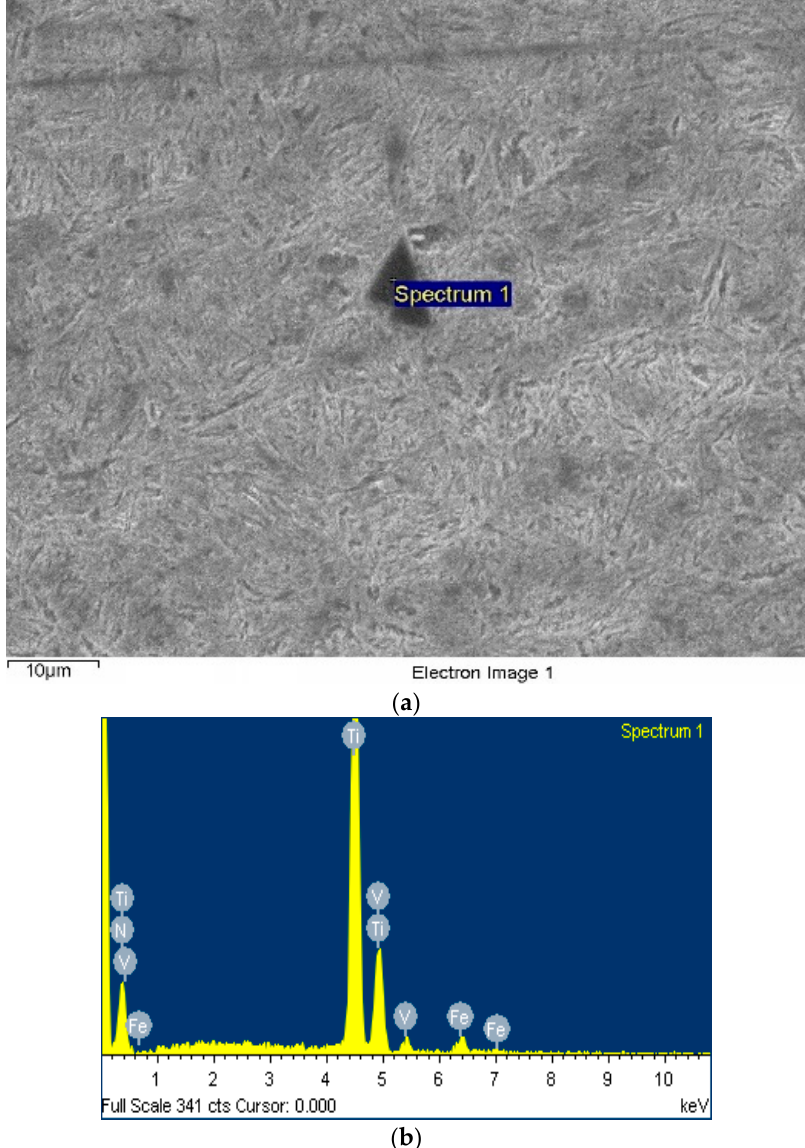
Figure 5. ( a ) The scan results of the secondary phase in 50CrVA-S1# and ( b ) corresponding energy dispersive spectroscopy (EDS) analysis.